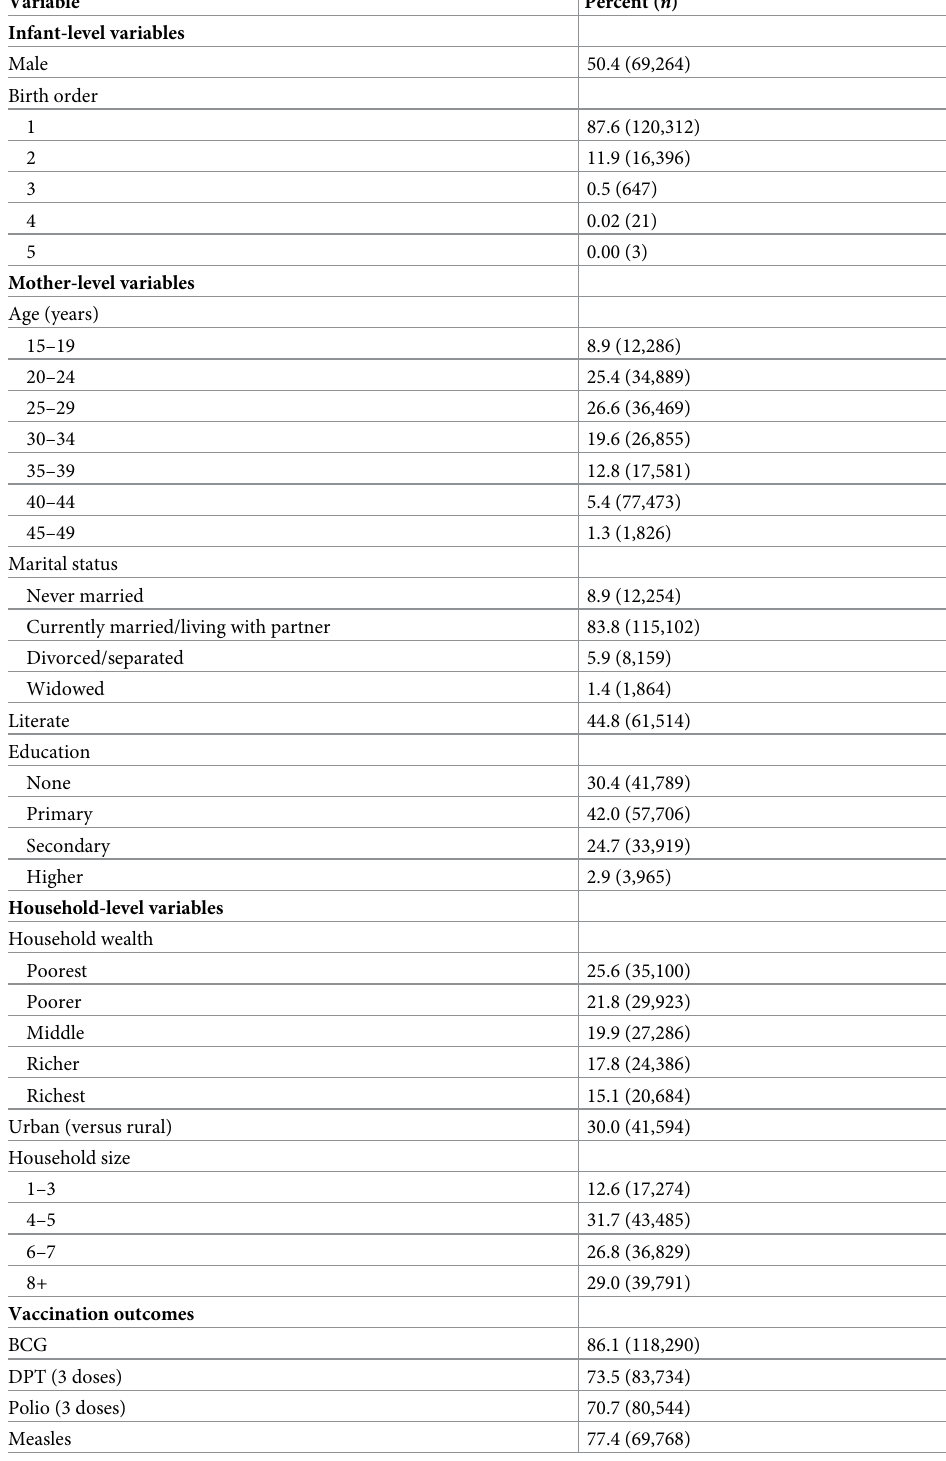
Table 2. Descriptive statistics of children born between 2011 and 2019 included in the analysis ( n =